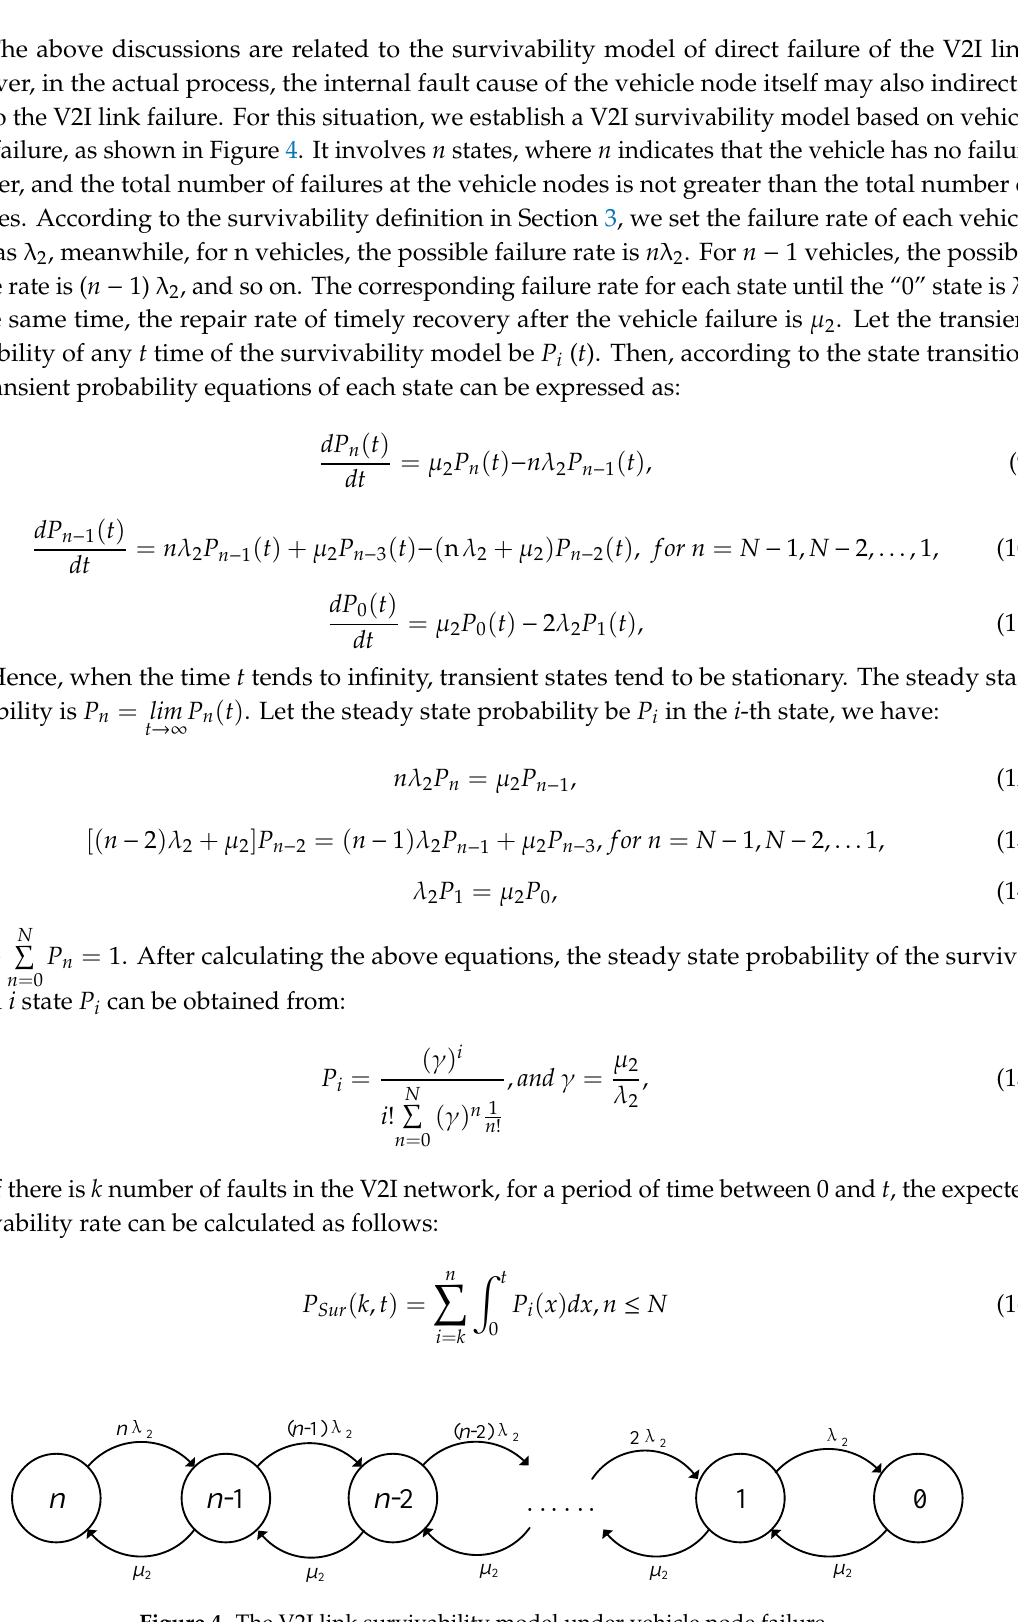
Figure 4. The V2I link survivability model under vehicle node failure.